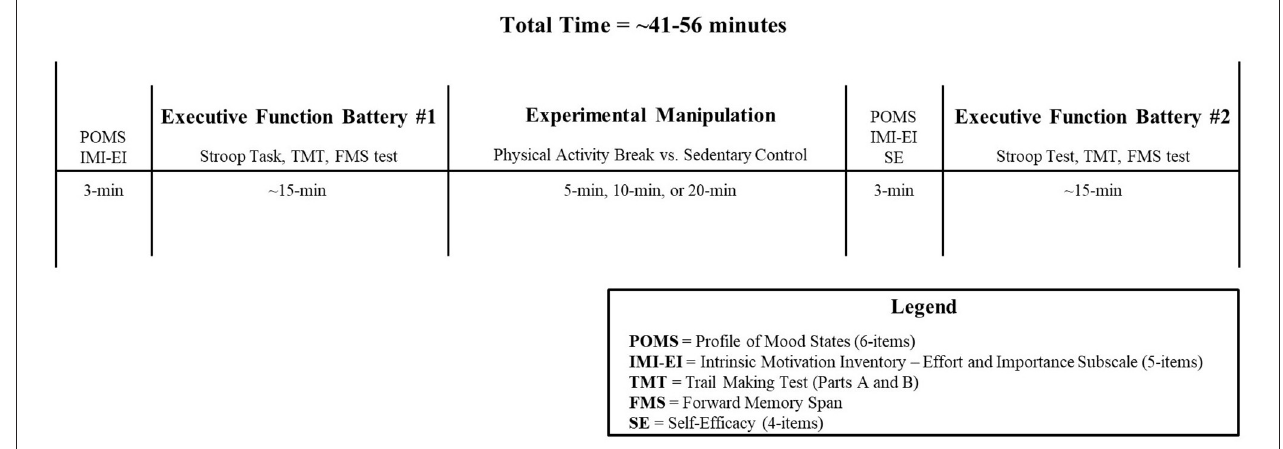
FIGURE 2 | Experimental